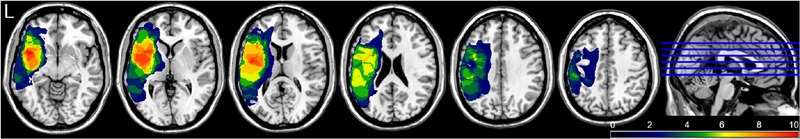
Lesion overlay maps of patients in different brain layers. Different colors indicate the number of lesion overlaps; red colored areas indicate lesion overlap regions in all 10 patients.